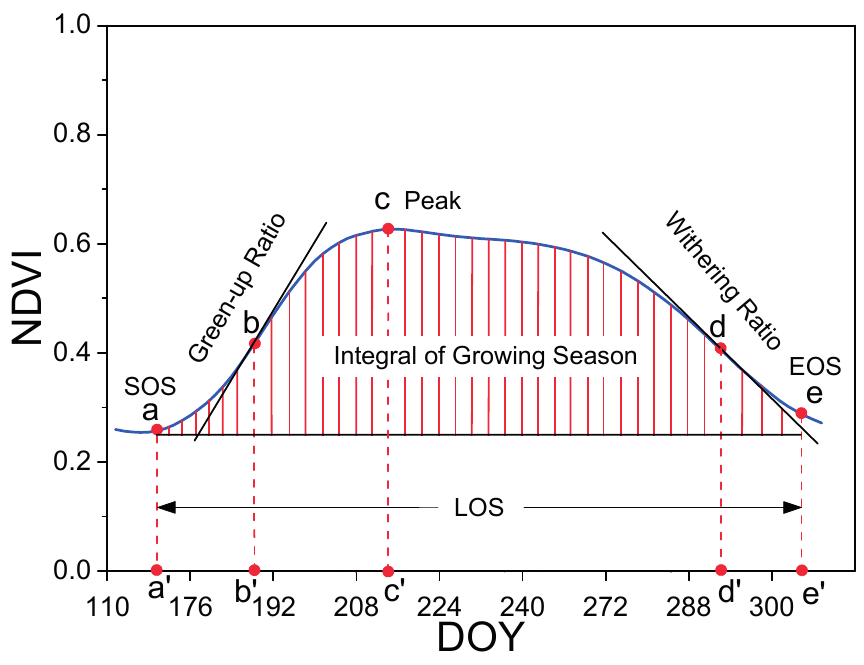
Figure 6. C3 and C4 time-series NDVI curve and extracted features. Time-series NDVI curve features: Start of Season (SOS), green-up ratio, peak, withering ratio, End of Season (EOS), Length of Season (LOS), integral of growing season, and their corresponding